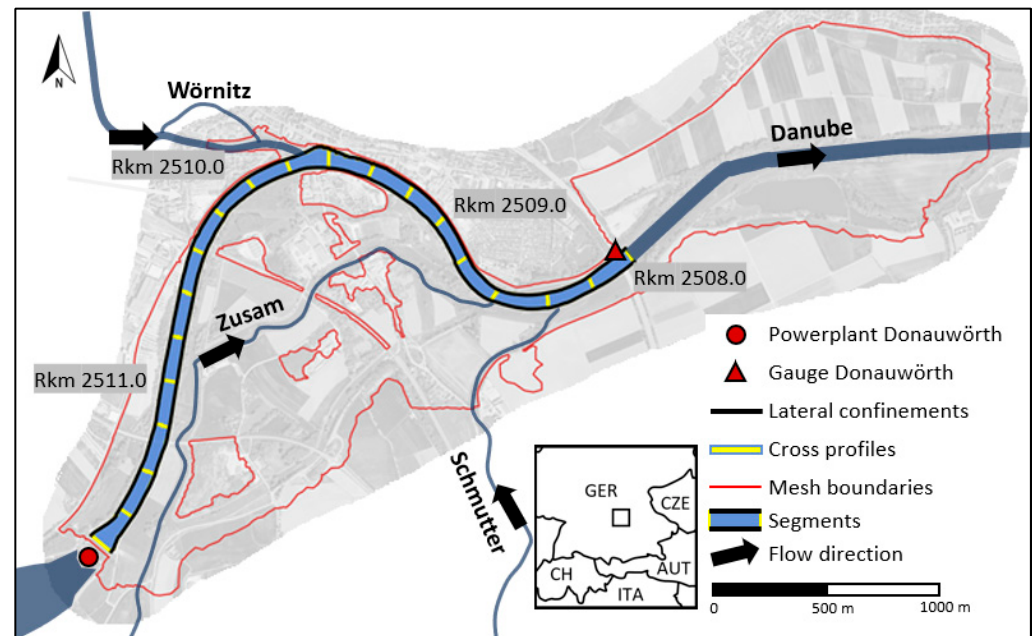
Figure 1. Overview of the study area in Donauwörth.